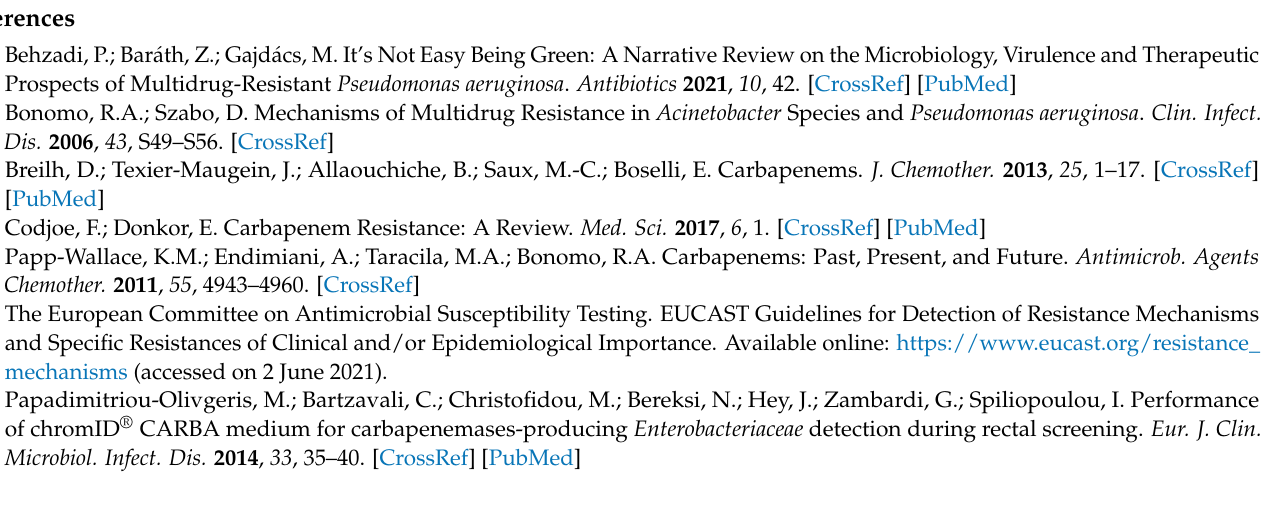
Table S2: methods used to detect the activity of carbapenemases and/or carbapenemase encoding genes in the tested and reference